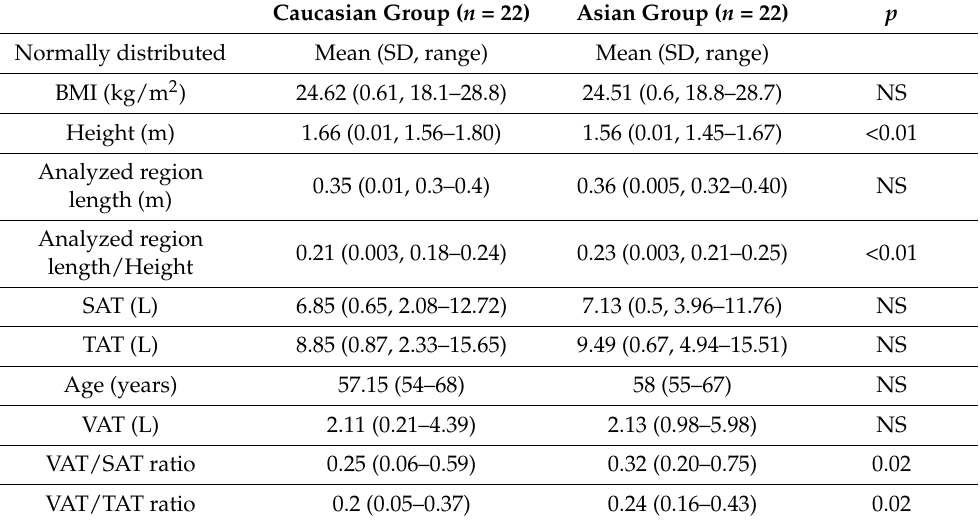
Table 2. Characteristics of each group and significance value of difference between the two groups (p). “Analysed region” refers to the volume of interest, from the top of the liver to the middle of the femoral head. Caucasian Group ( n = 22) Asian Group ( n = 22)